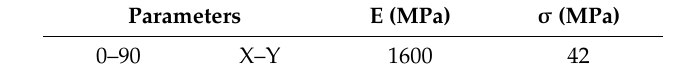
Table 7. Mechanical properties imposed in the virtual testing conditions.